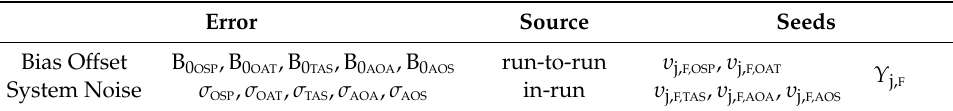
Table 8. Air data sensor error sources.